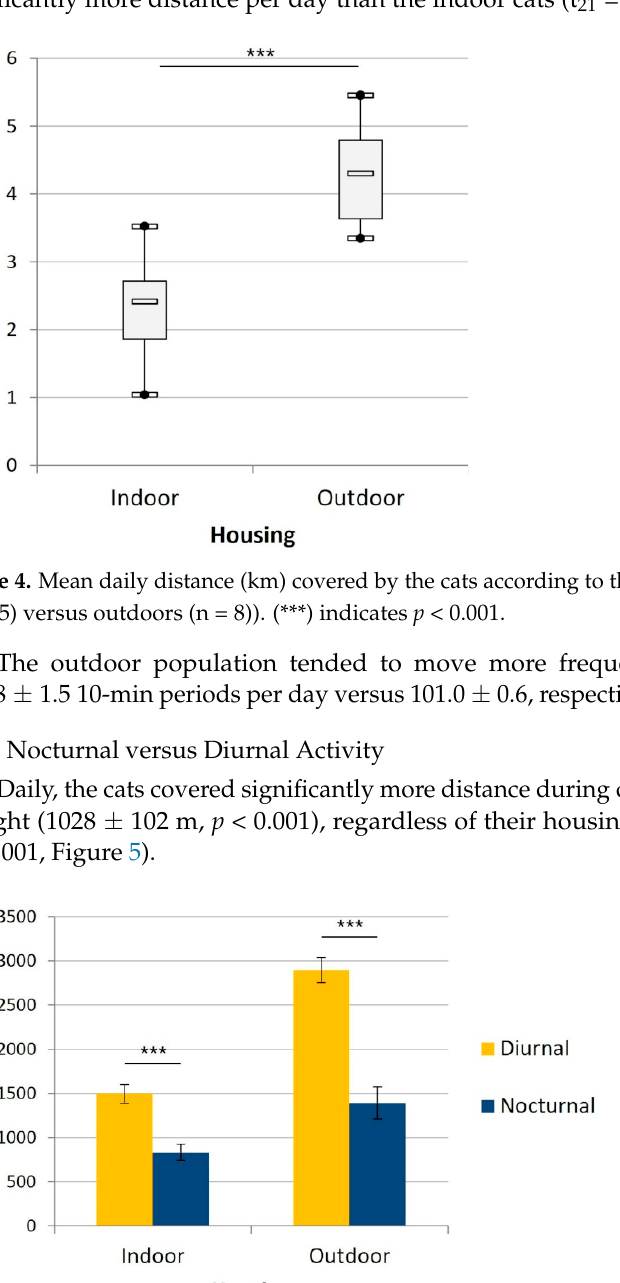
Figure 3. Mean amplitude ( a ) and interdaily stability ( b ) of the activity rhythm of the cats according to their housing condition (indoors (n = 15) versus outdoors (n = 8)). (*) indicates p < 0.05, (**) indi- cates p < 0.01.